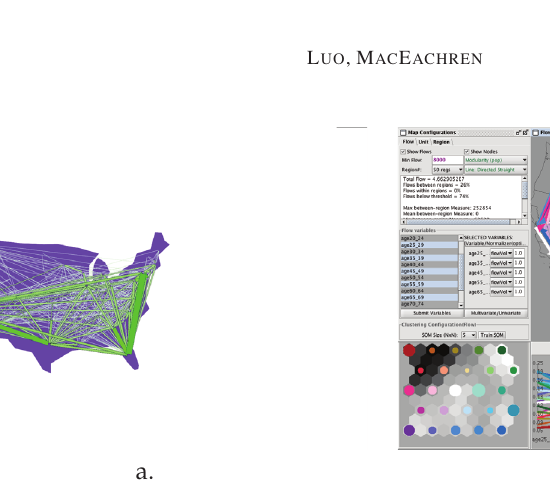
Figure 3: (a) State to state migration from 1995 to 2000. Adapted from Figure 7 in [181] with Flow Mapper program from CSISS.org. (b): Flow mapping and multivariate visual- ization of large spatial interaction data. Figure courtesy of Diansheng Guo. For additional information on the research it is derived from, see